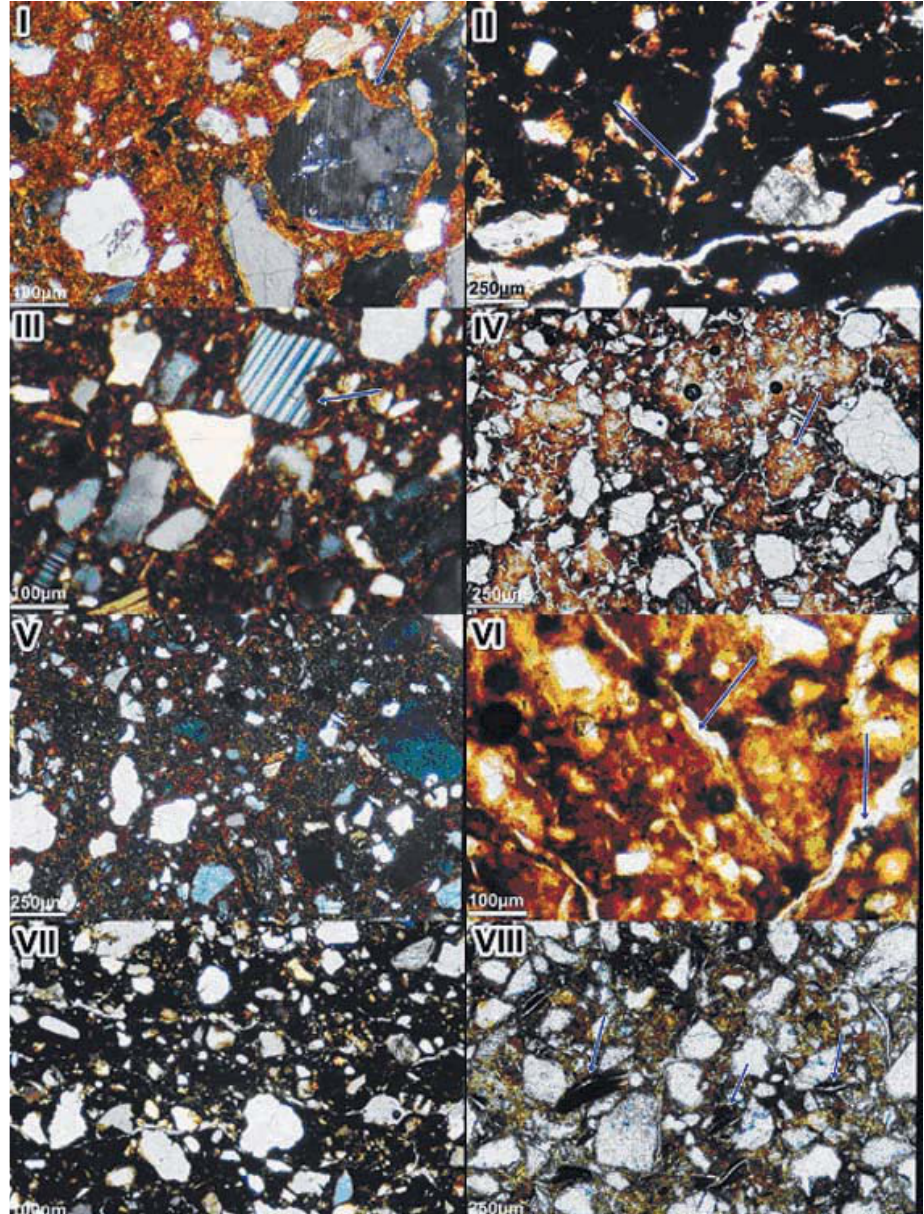
Figura 2. Fotomicrografias mostrando: contextura-b granoestriada e alteração de plagioclásio no horizonte A do perfil 4 e do perfil 5 (I e III); estrutura em blocos angulares no horizonte Bt do perfil 4 (II); PDR do tipo porfírico no horizonte Bt do perfil 5 (IV e V); poros aplanados no BC do perfil 5 (VI); parte da microestrutura fissural do horizonte A (IV); e abundantes flocos de mica parcialmente alterados na camada R do perfil 6 (VII e